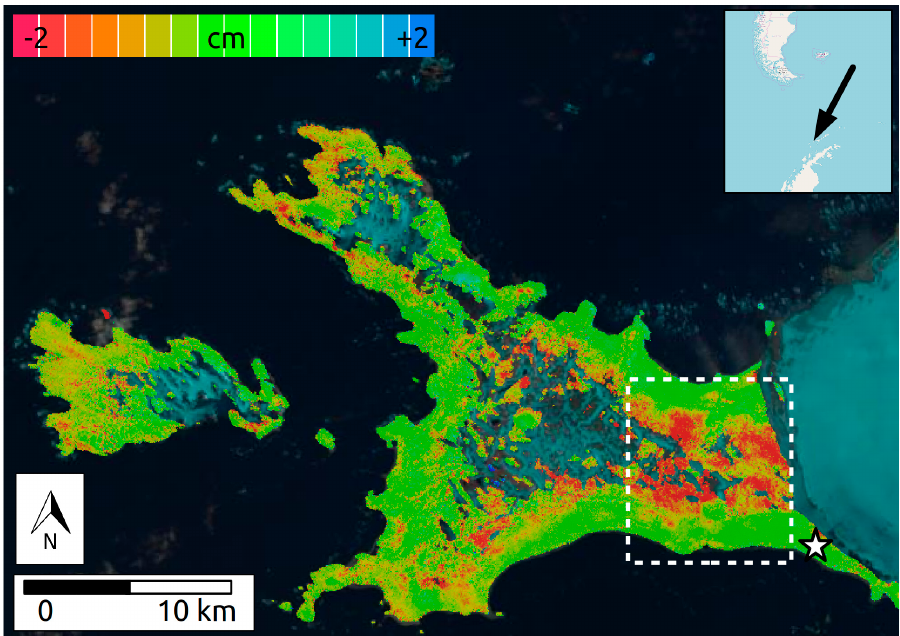
10 of 19 Figure 9. Time series of displacement in the line ‐ of ‐ sight direction over an upland area (P1) and a thermokarst basin (P2) within the same terrace on Kurungnakh Island in the southern central Lena River Delta. For location see Figure 8. Map data are from Google, DigitalGlobe. The summer subsidence is highest on the plateau surfaces (P1 and P2 in Figure 10), where permafrost is continuous and periglacial features, such as patterned ground, stone streams and solifluction lobes, are ubiquitous [24,45]. The time ‐ series show a period of increasing subsidence from late December to mid ‐ February, followed by general stabilization in both years (Figure 11). In 2017, small amounts of subsidence were observed again in late March. Borehole temperatures from Papagal in Hurd Peninsula (Figure 12),